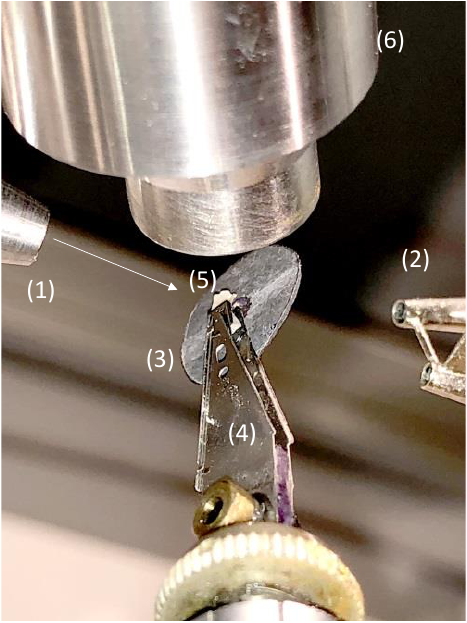
Figure 2. Photograph of the fiber sample holder used for X-ray scattering analysis in transmission mode in the Gemini A Ultra diffractometer. (1) X-ray delivery tube (CuK α ), (2) two-well beamstop, (3) lead washer shield, (4) elastic pliers (collected from a 3.25 (cid:48)(cid:48) hard disk), (5) sample, (6)